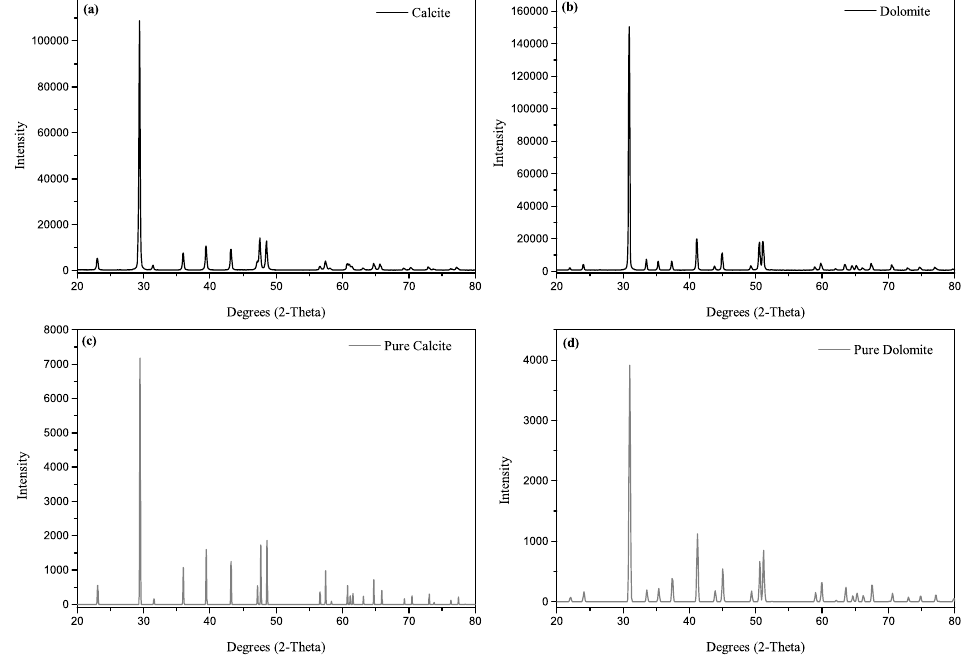
Figure 1. X-ray diffraction (XRD) patterns of the calcite ( a ) and dolomite ( b ) powders used in this study mapped with pure materials ( c , d ). Top: Samples employed in this work. Bottom: Reference data from literature